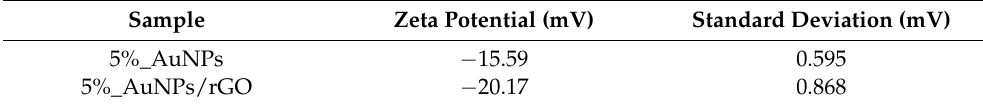
Table 2. Zeta potential values of AuNPs synthesized before and after rGO addition.